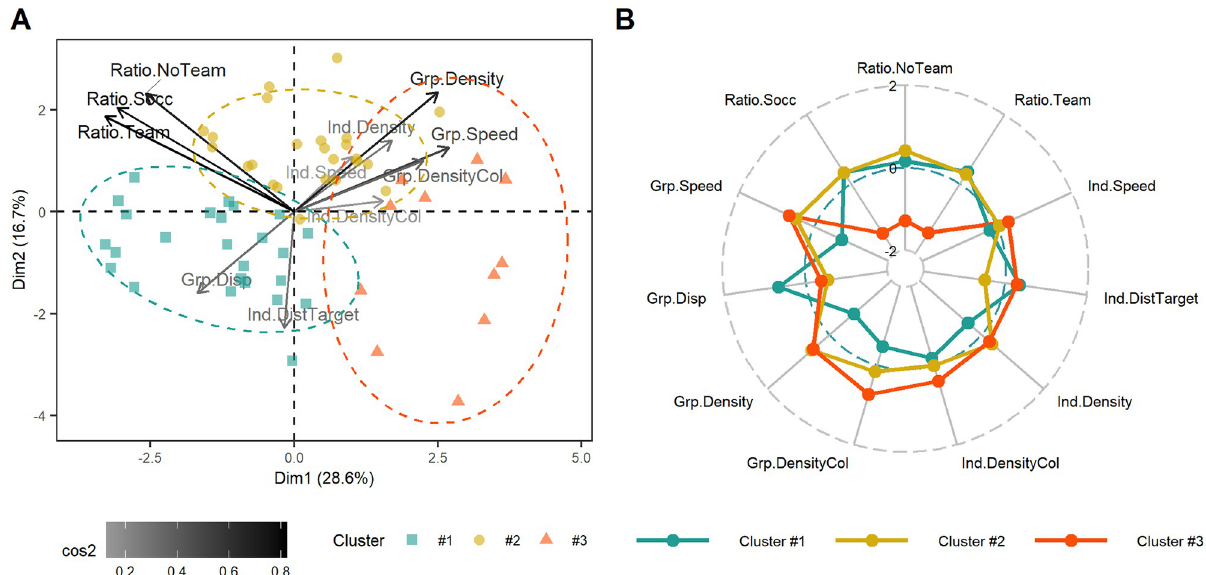
Fig 5. Exploratory analysis for target-players of UNSTRU condition. A) PCA Biplot with the investigated variables and individual target-players projected on the first two dimensions returned by the PCA. The color gradient expresses the amount of variance conserved on this plane for each variable. The individual target-players’ shape and color are given with respect to their respective cluster computed with the HCPC algorithm. B) Radar plot with centered-reduced variables taken by each cluster of target-players returned by HCPC algorithm. The more central the plot of the variable, the lower its value and conversely. The middle circle line stands for the mean value taken by each variable considering all target-players. The more the value of a cluster is far from the middle circle line, the more the target-players of this cluster are different from the others.